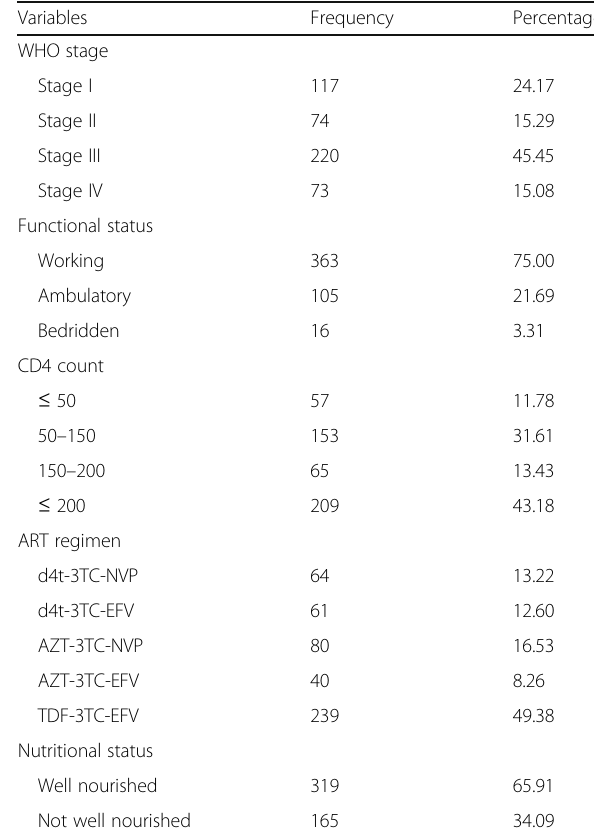
Table 2 Baseline clinical characteristics of HIV-positive adults